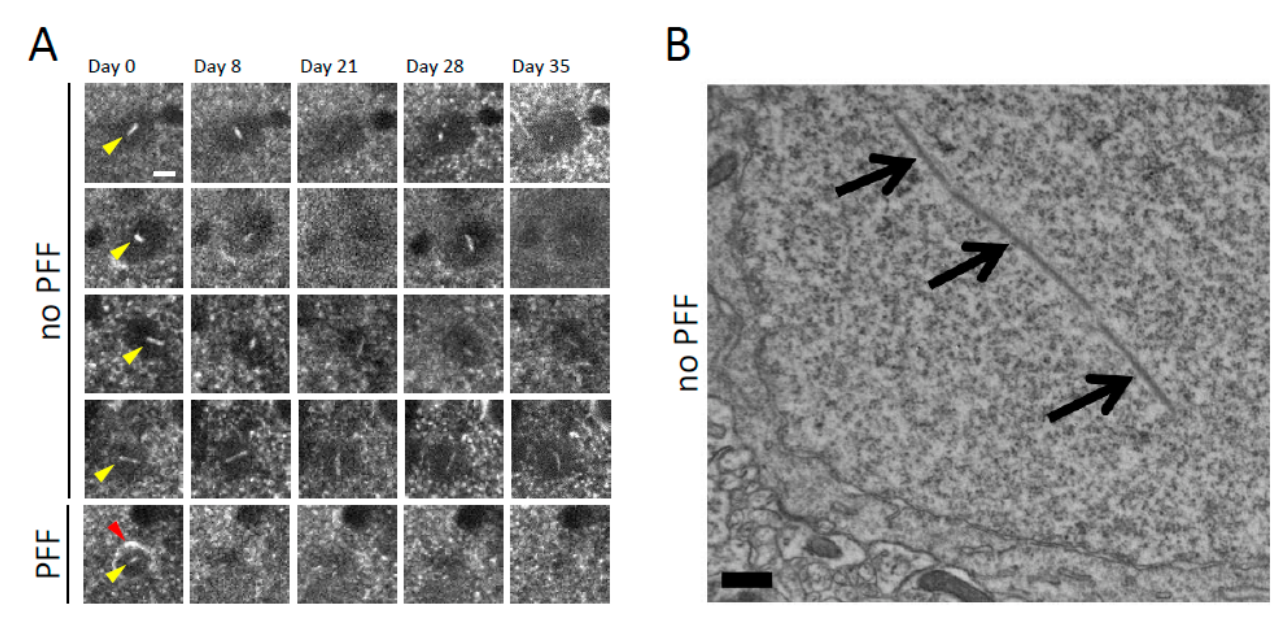
Figure 1. Intranuclear alpha-synuclein-GFP rod-like aggregates form spontaneously in transgenic mouse cortical neurons and in neurons bearing somatic Lewy pathology after PFF injection. ( A ) Top rows: In vivo multiphoton imaging performed serially over 5 weeks shows four different examples (each row a different cell) of mouse cortical neurons in Syn-GFP transgenic animals bearing intranuclear Syn-GFP rod-like aggregates (yellow arrowheads). Intranuclear aggregates are mobile within the nucleus at this time scale, changing orientation within the nucleus over the course of days. Bottom row: In vivo imaging from a cortical neuron bearing a somatic Syn-GFP Lewy inclusion (red arrowhead) induced by alpha-synuclein PFF injection, also with an intranuclear aggregate (yellow arrowhead), on day 0 of imaging, which degenerates and disappears before day 8. Scale bar: 5 μ m. ( B ) Electron micrograph of cortical neuron in Syn-GFP transgenic animal (with no PFF injection) demonstrating a rod-like intranuclear aggregate (arrows). Scale bar: 500 nm.